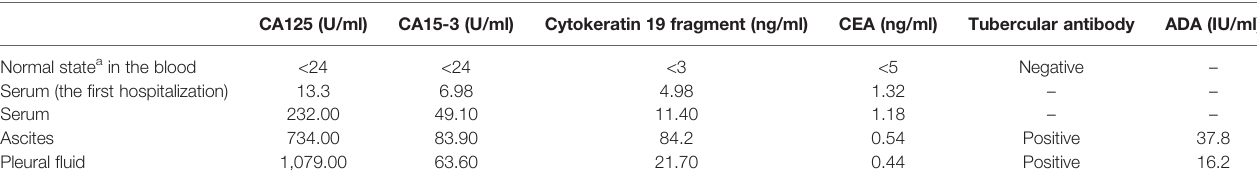
TABLE 1 | Laboratory results for serum, ascites, and pleural fl